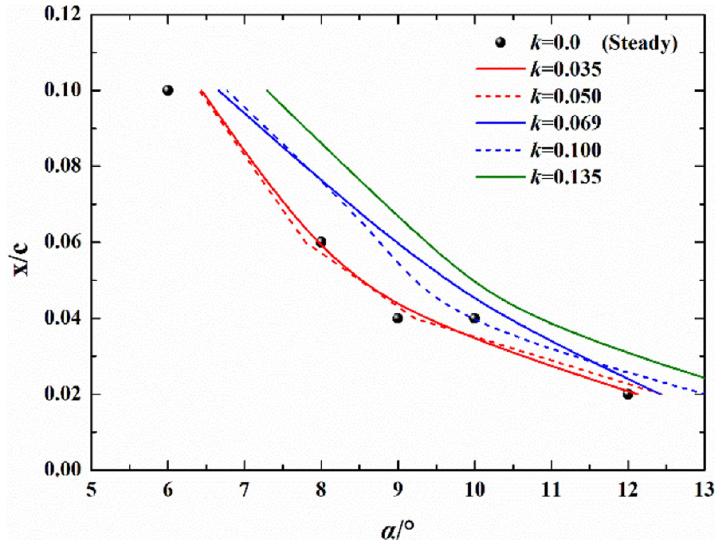
Fig. 12 Effect of reduced frequency on transition